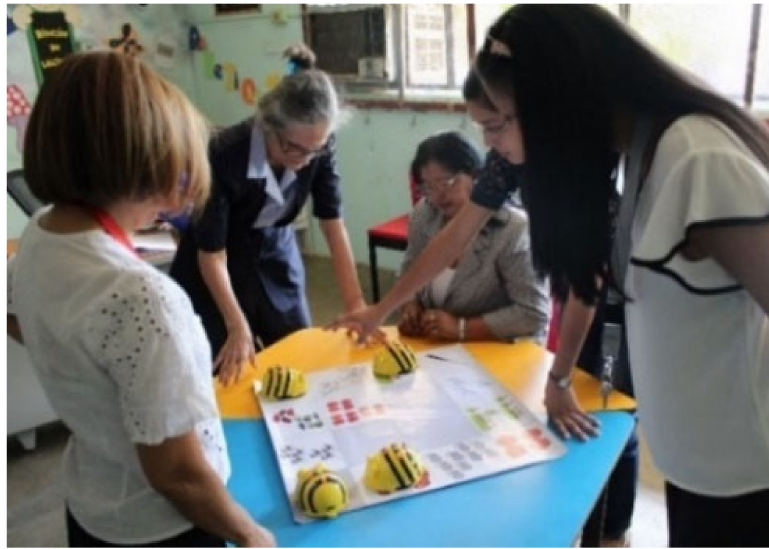
Figure 2. Practical workshop on the use of Bee-Bot.